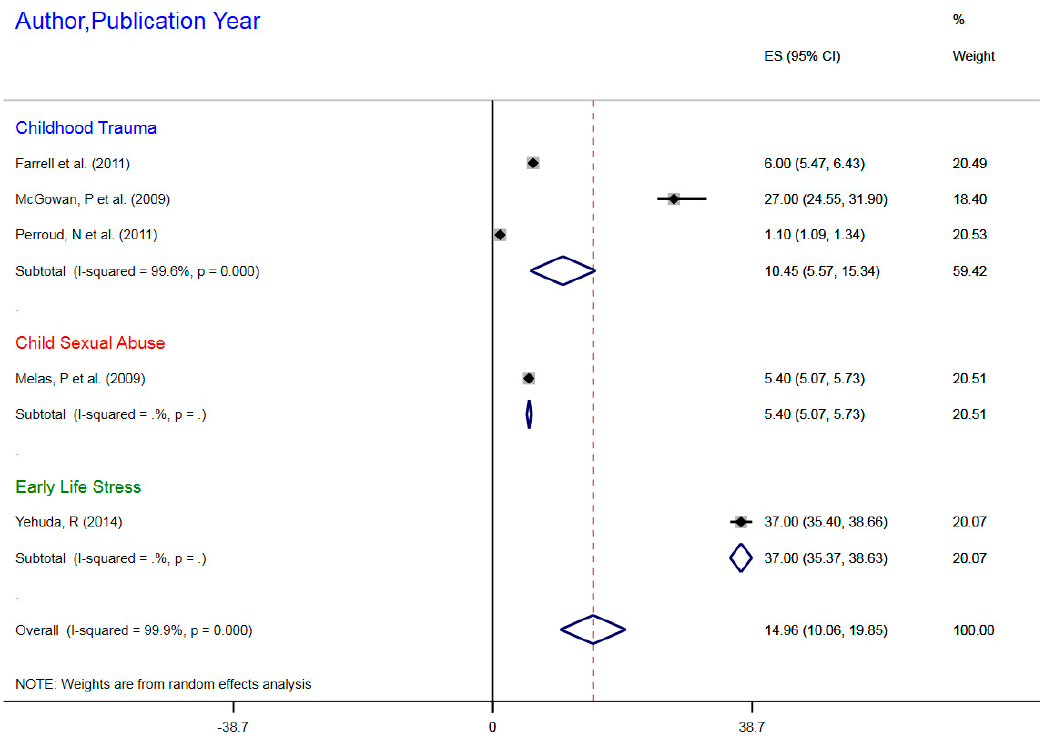
Figure 3. Meta-regression of NR3C1 (Glucocorticoid receptor) gene DNA Methylation in Social Adversity and Major Depressive Disorder Correlation.